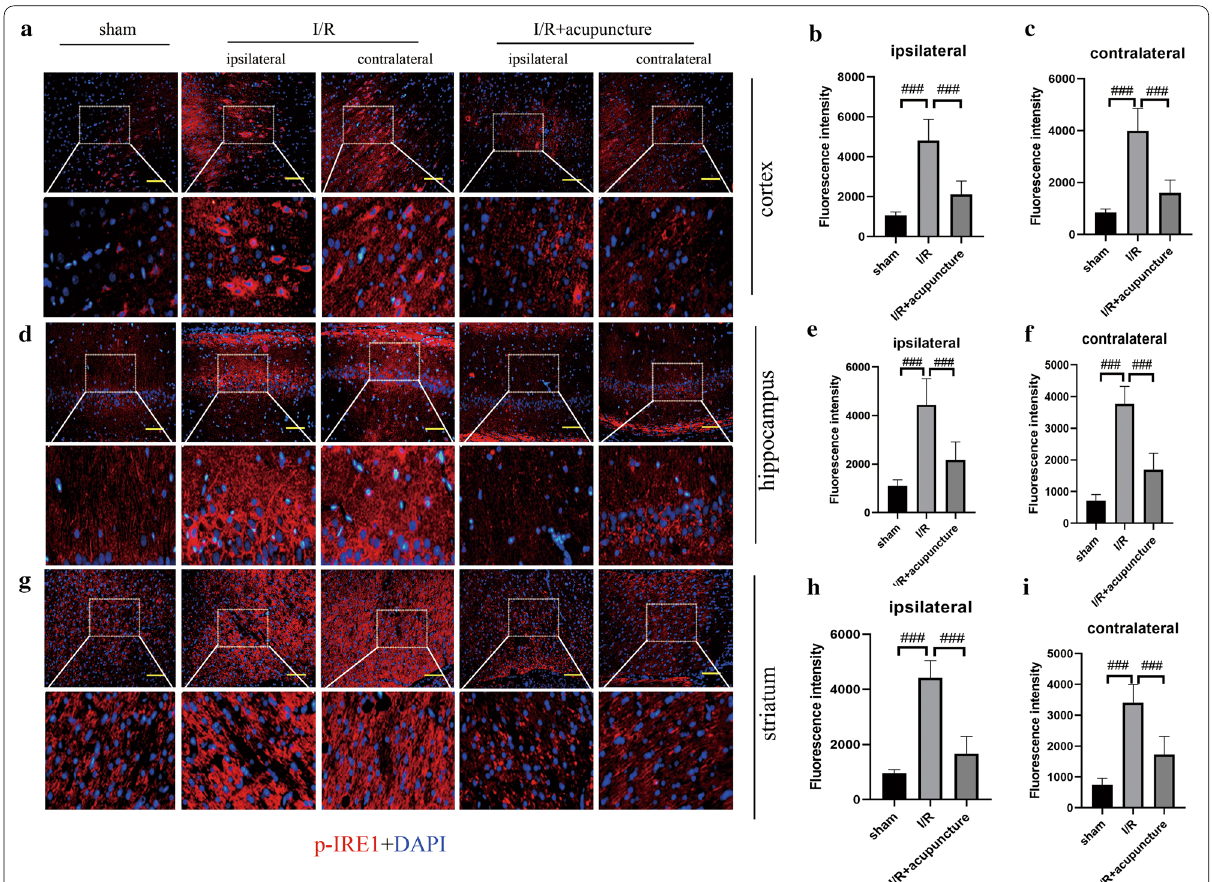
Fig. 6 Acupuncture repressed cerebral ischemia–reperfusion (I/R) injury-induced endoplasmic reticulum (ER) stress via inhibiting phosphorylated inositol-requiring protein 1 (p-IRE1) expression. The expression of p-IRE1 (red) in cortex ( a – c ), hippocampus ( d – f ), and striatum ( g – i ) regions of contralateral and ipsilateral brains at 72 h after reperfusion was assessed by immunofluorescence analysis. The nuclei were counterstained with DAPI (blue). Scale bars, 100 μm. Results represent at least three independent experiments. Results represent at least three independent experiments. Each experimental result was presented as mean standard deviation (n 6). ### P < 0.001 versus the indicated ± =